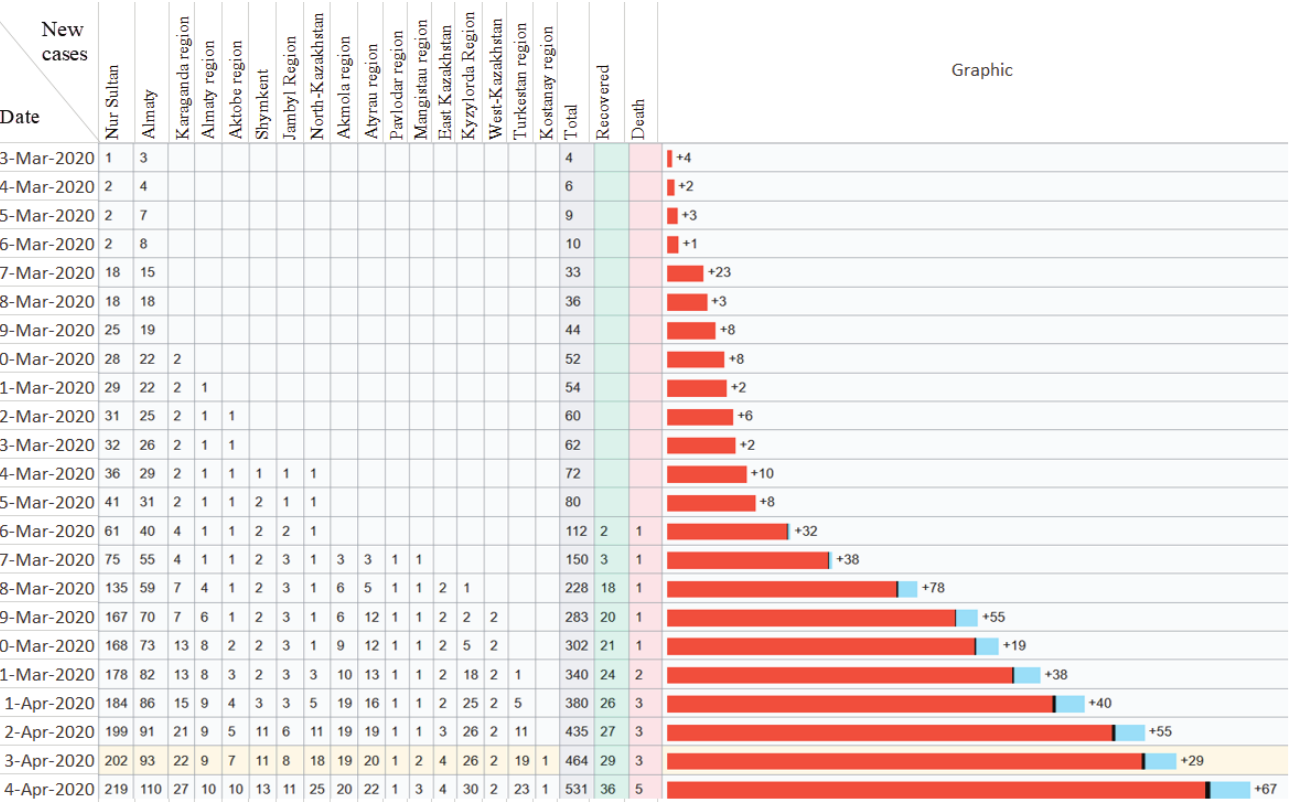
Figure 1 - Map of confirmed cases of COVID-19 in administrative divisions of Kazakhstan. The cities Nur-Sultan, Almaty and Shymkent are represented in separate areas [3].